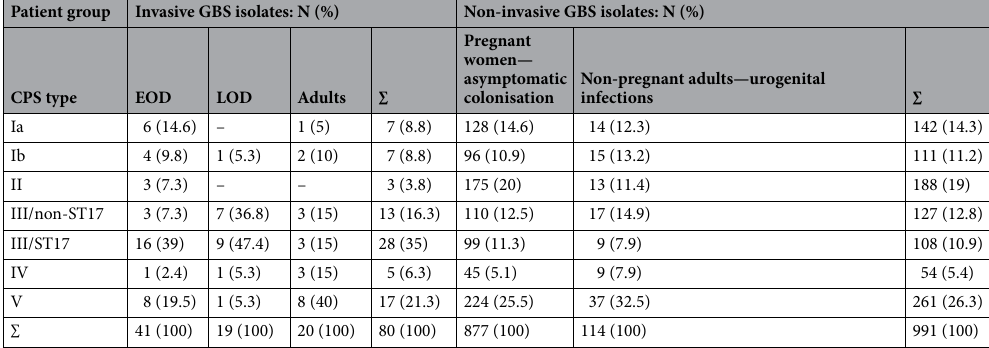
Table 2. Distribution of capsular polysaccharide types and hypervirulent clone III/ST17 among 1071 invasive and non-invasive isolates of Group B streptococci within different patient groups. CPS capsular polysaccharide, EOD early-onset disease, LOD late-onset disease, GBS Group B streptococcus.